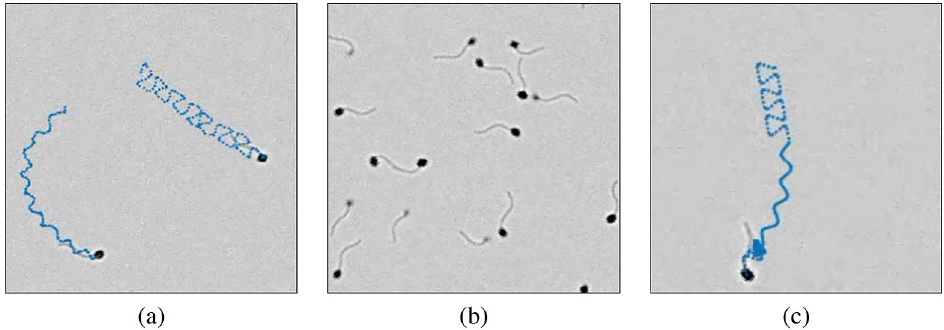
Figure 17. ( a ) Simulation image of two cells with additive random noise; tracks of the two cells shown in blue. The random noise in this example is Gaussian random variable. ( b ) Simulation image of sperm cells with variable intensity. ( c ) Simulation image of a sperm cell making transition to other swimming modes.